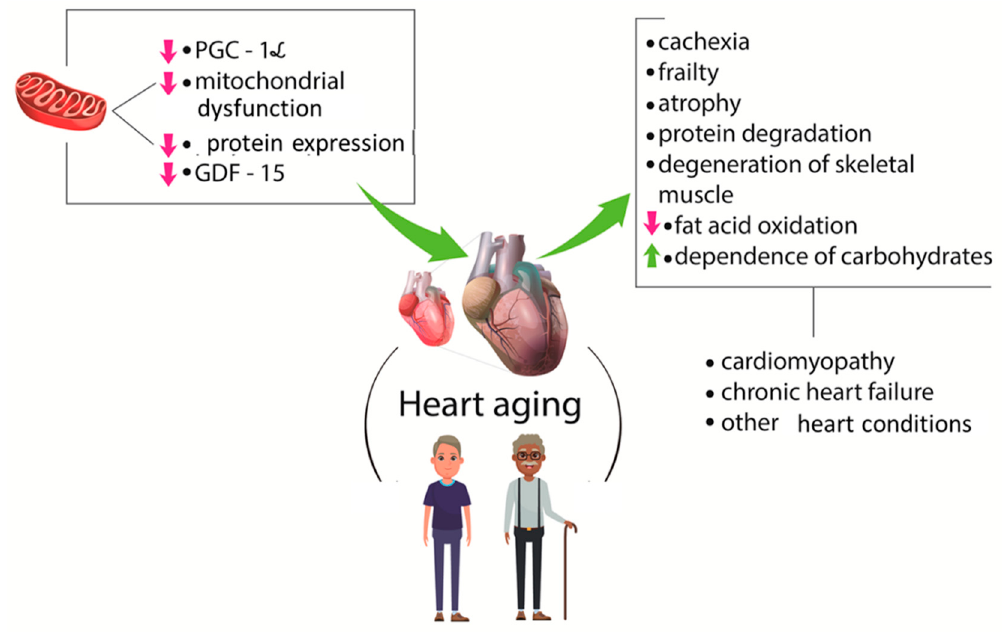
Figure 3. The relationship between sarcopenia and cardiovascular diseases. The aging process is related to mitochondrial dysfunction and reduction in protein synthesis and PGC-1 α and GDF-15 levels. These factors are linked to atrophy, denervation, frailty, and modifications in lipid and carbohydrates metabolism that are associated with heart problems. PGC-1 α : peroxisome proliferator-activated receptor gamma coactivator-1 alpha.